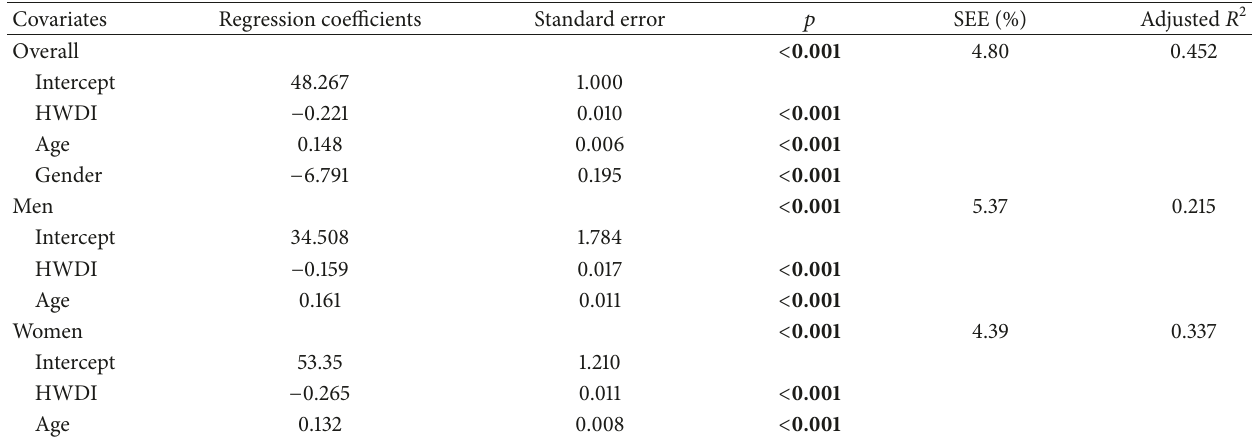
Table 2: Regression analysis for changes in BF% with HWDI, age, and